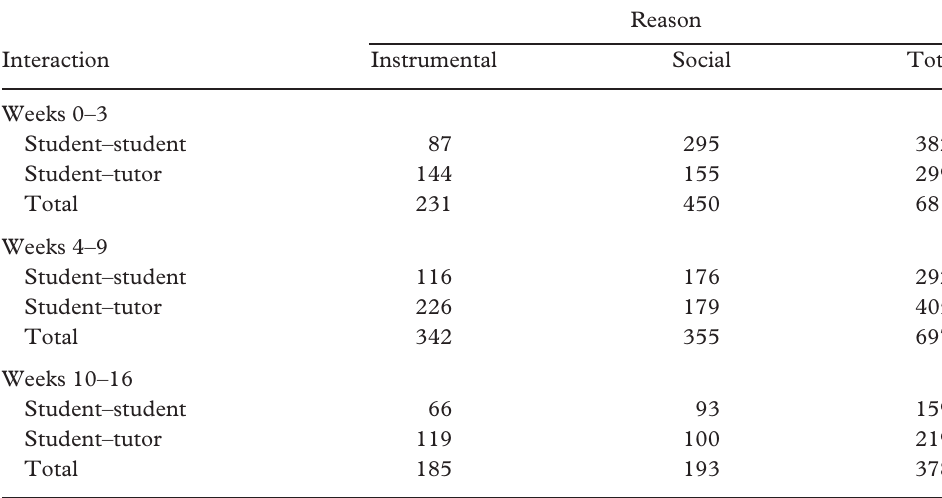
Table 2. Summary of student–student and student–tutor postings for instrumental and